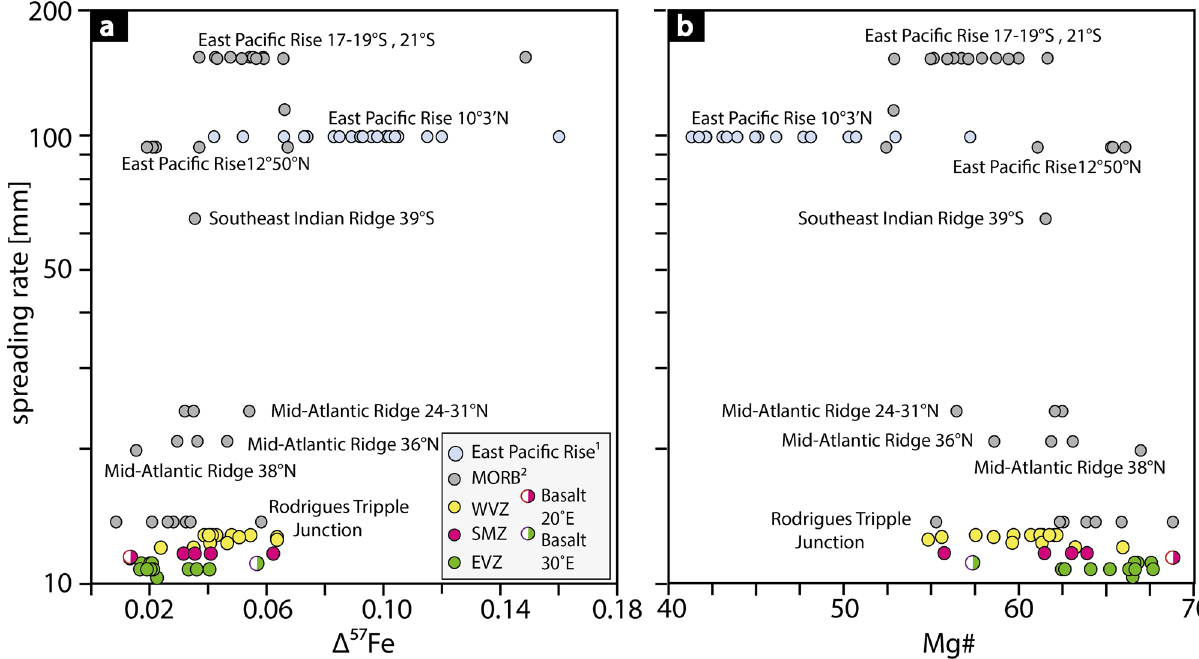
Figure 6. The effect of spreading rate on Δ 57 Fe and Mg#. (a) Δ 57 Fe co-varies positively with increasing spreading rate and Mg# (b) decreases with increasing spreading rate, in particular within the Gakkel Ridge basalts. 1—Iron isotope data from the East Pacific Rise are compiled from Chen et al. 49 . 2—Iron isotope data for MORBs are taken from Teng et al. 21